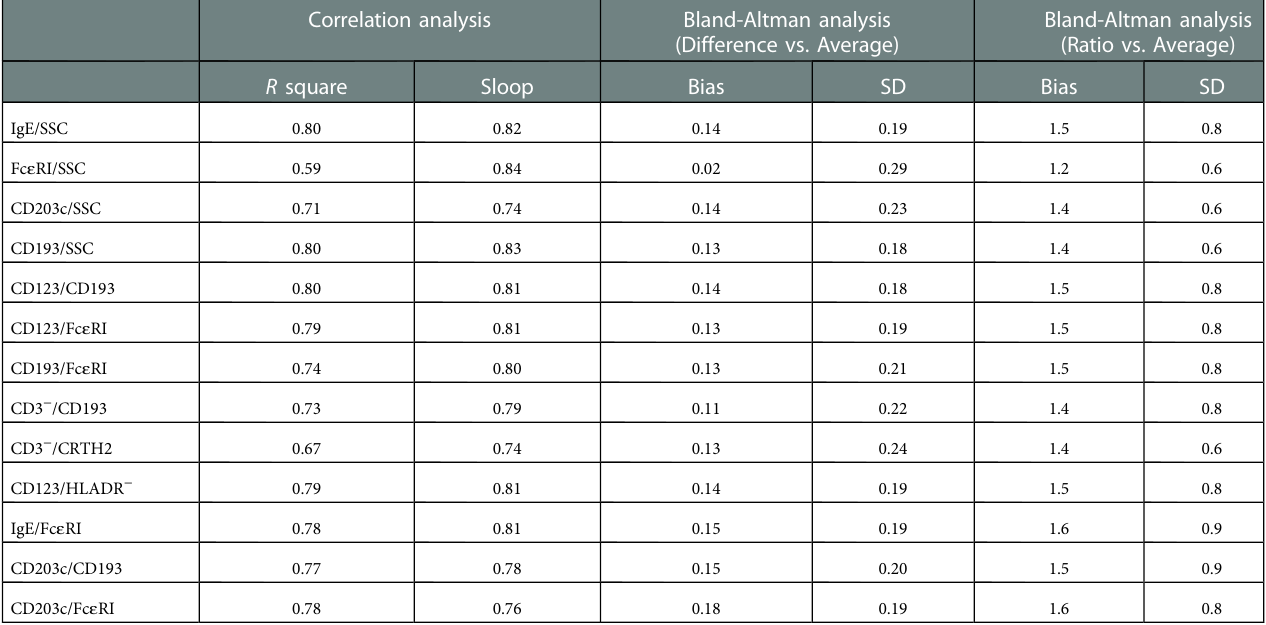
TABLE 5 Correlation between the different fl ow cytometry methods of identifying basophils and the results of a CBC obtained using the XN11 automated hematology analyzer at an accredited reference laboratory. Correlation